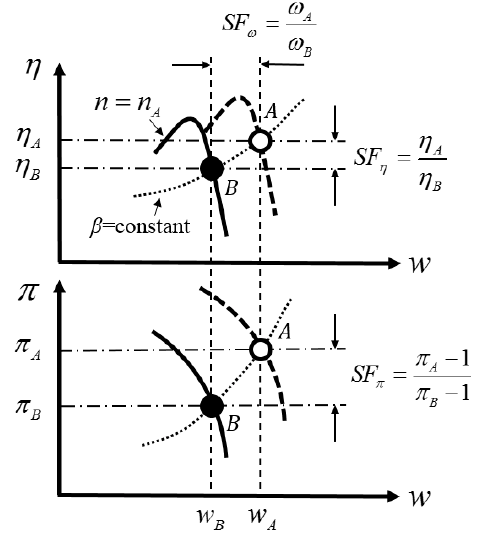
Figure 3. Definition of scaling factor on a compressor map.